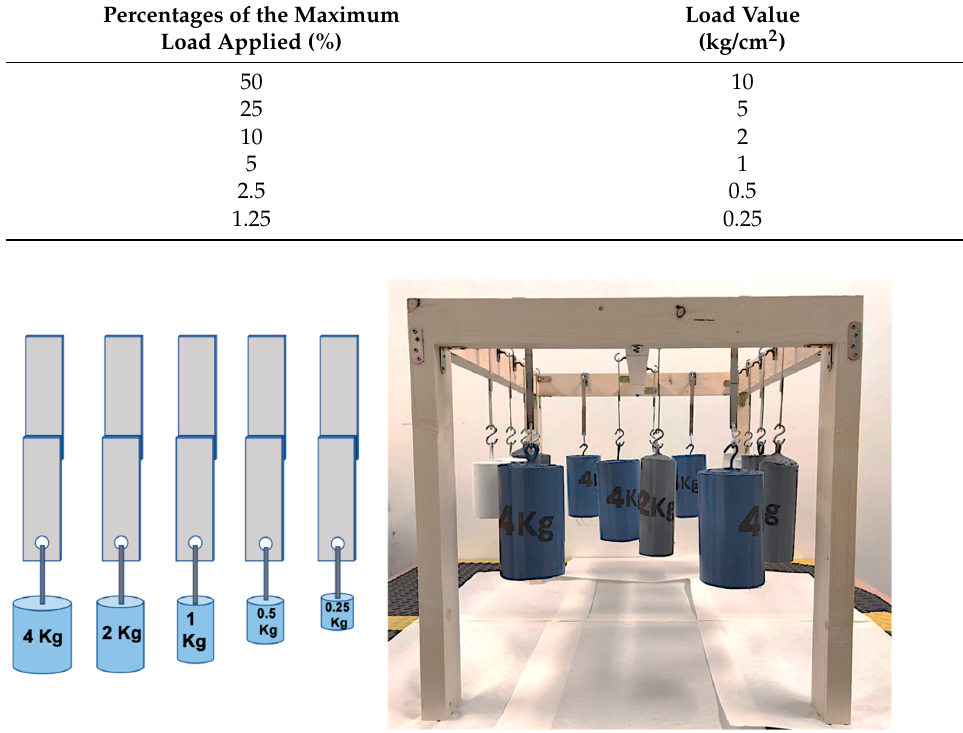
Table 3. Different loads used in the creep tests.